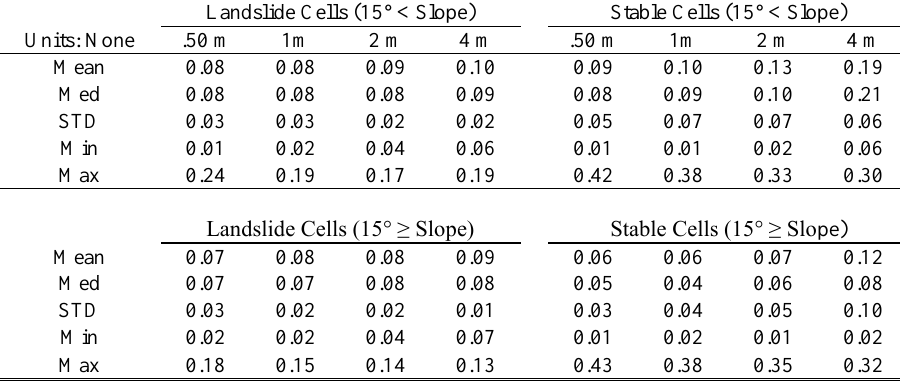
Table 6. Statistics of hillshade surface feature.